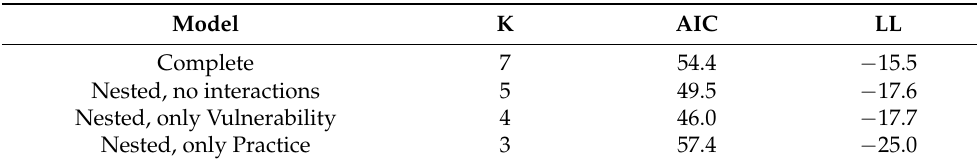
Table 6. Model 3, crop yield model selection table. The optimal model (“Nested, only Vulnerability”, shown in boldface) was selected according to the lowest AIC and greatest log-likelihood (K: number of parameters; LL: log-likelihood; df: degrees of freedom).